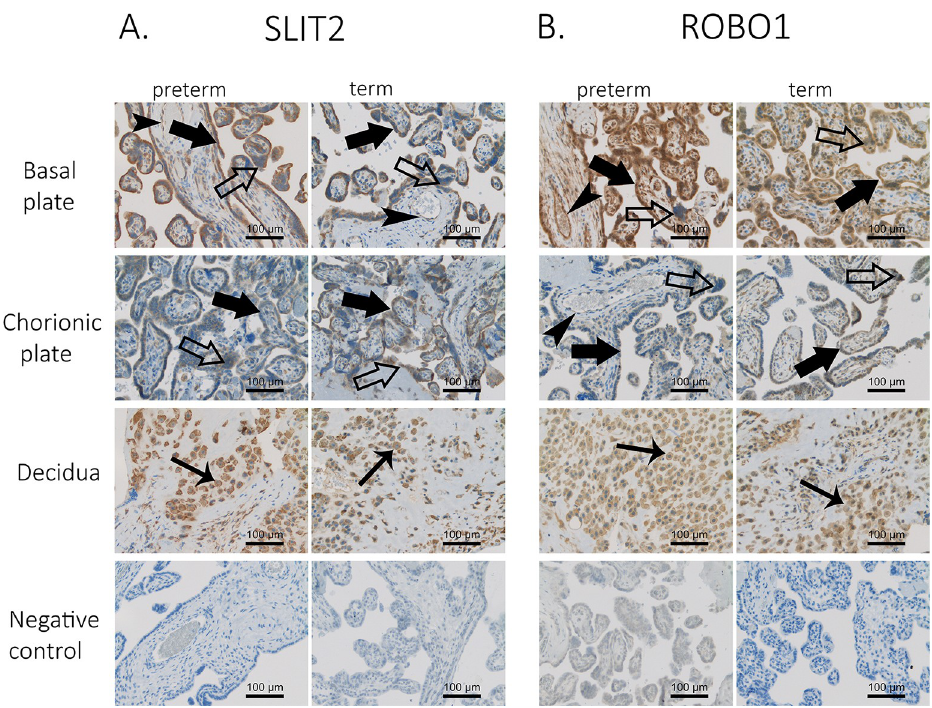
Fig 3. Placental localization of SLIT2 and ROBO1 in spontaneous preterm and term births. Samples from 18 placentas were immunostained with anti-human SLIT1 (A) and ROBO1 (B) antibodies. Twelve of the placentas were from SPTB deliveries, and six were from spontaneous term deliveries. Two samples from each placenta were stained; one sample from the basal plate (maternal side) and the other from the chorionic plate (fetal side). Immunostaining is indicated by filled large arrows in cytotrophoblasts, unfilled large arrows in syncytiotrophoblasts, filled small arrows in decidual trophoblasts, and filled arrowheads in capillary endothelial cells. Original magnification is 20 × in all figures. Control represents isotype controls for immunostaining. Scale bar, 100 μ